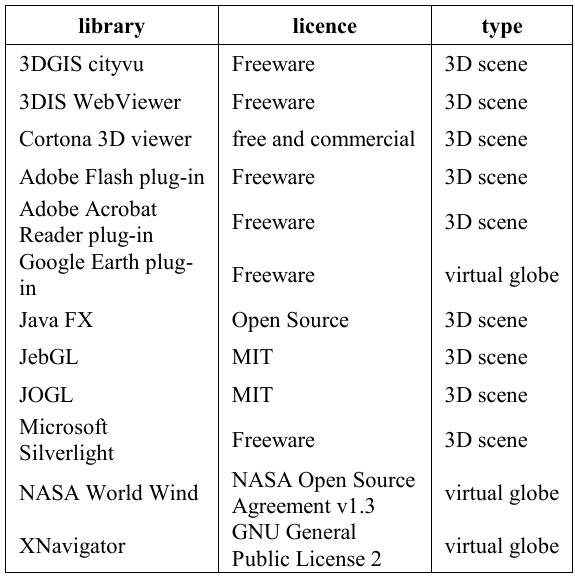
Table 1. Overview of plug-in based solutions for the visualization of 3D spatial